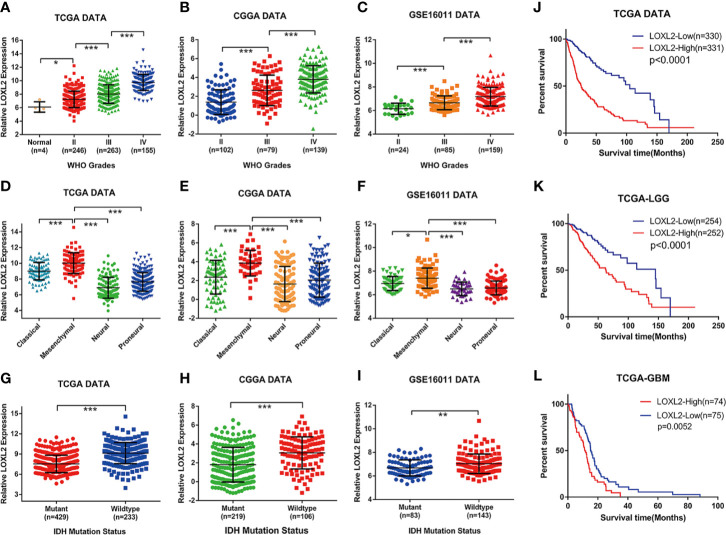
The expression characteristics of LOXL2 in the public database. LOXL2 levels were checked in different grades (A), subtypes (D), and isocitrate dehydrogenase (IDH) mutation statuses (G) in The Cancer Genome Atlas (TCGA) cohort. LOXL2 expression levels assessed in different grades (B), subtypes (E), and IDH mutation statuses (H) in the Chinese Glioma Genome Atlas (CGGA) cohort. LOXL2 expression levels assessed in different grades (C), subtypes (F), and IDH mutation statuses (I) in the GSE16011 cohort. Kaplan-Meier ananlysis examined the relationship between LOXL2 and overall survival of patients with all gliomas (J), LGG (K), and GBM (L) in TCGA. *P < 0.05; **P < 0.01; ***P < 0.005.